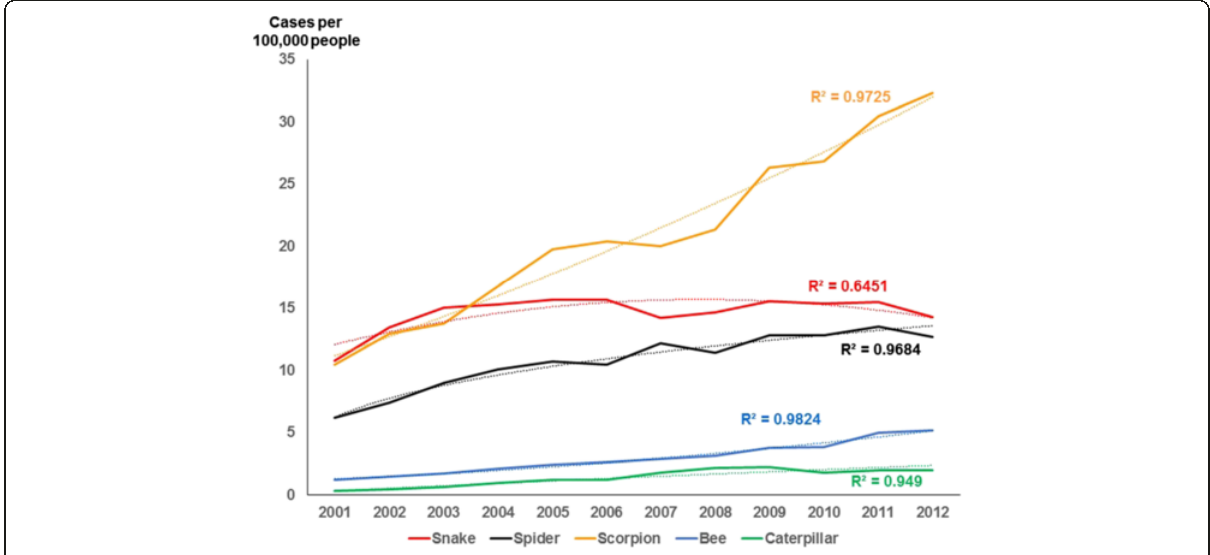
The average annual mortality (0,117 deaths per 100,000 inhabitants) increased in the same proportion (Table 4, Fig. 3). Regional incidences and mortalities (Table 5) showed: a predominance of snake envenomations in northern Brazil (North, Central-West and Northeast regions); a wide distribution of scorpion stings in all the country, although a higher incidence occurred in Northeast; incidence of spider bites mostly in southern Brazil; and insect attacks (bees and caterpillars) in the South. Inci- dence variations are detailed in Table 6.